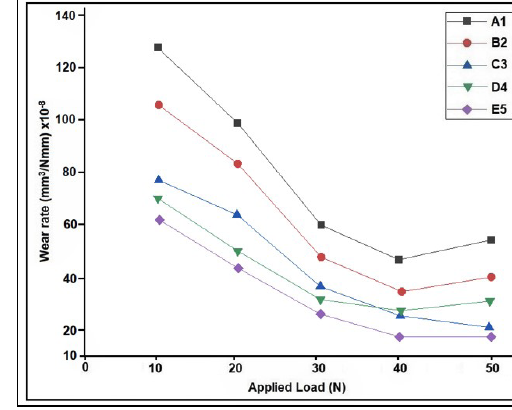
Figure 10. Wear rate Vs applied load at 3m/s sliding velocity. Figure 11. Wear rate Vs applied load at 5m/s sliding